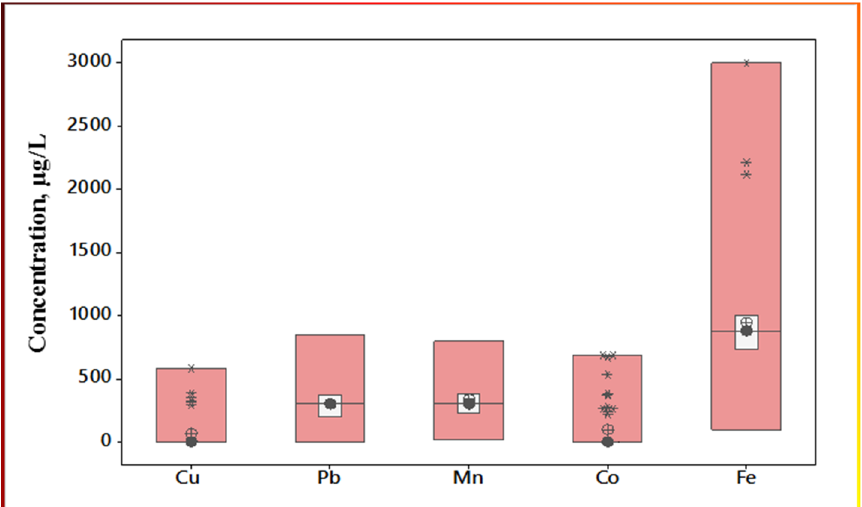
Figure 2. Box plot showing the measured trace elements distribution.